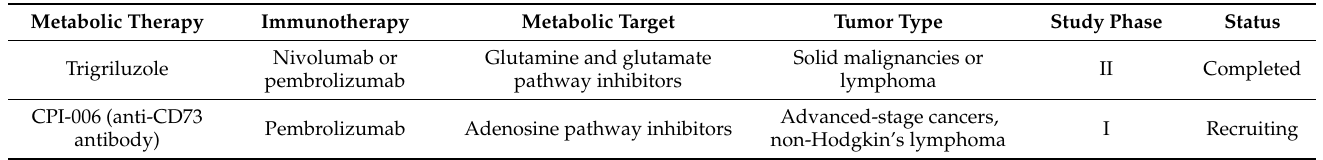
Table 2. Clinical trials of metabolic interventions combined with